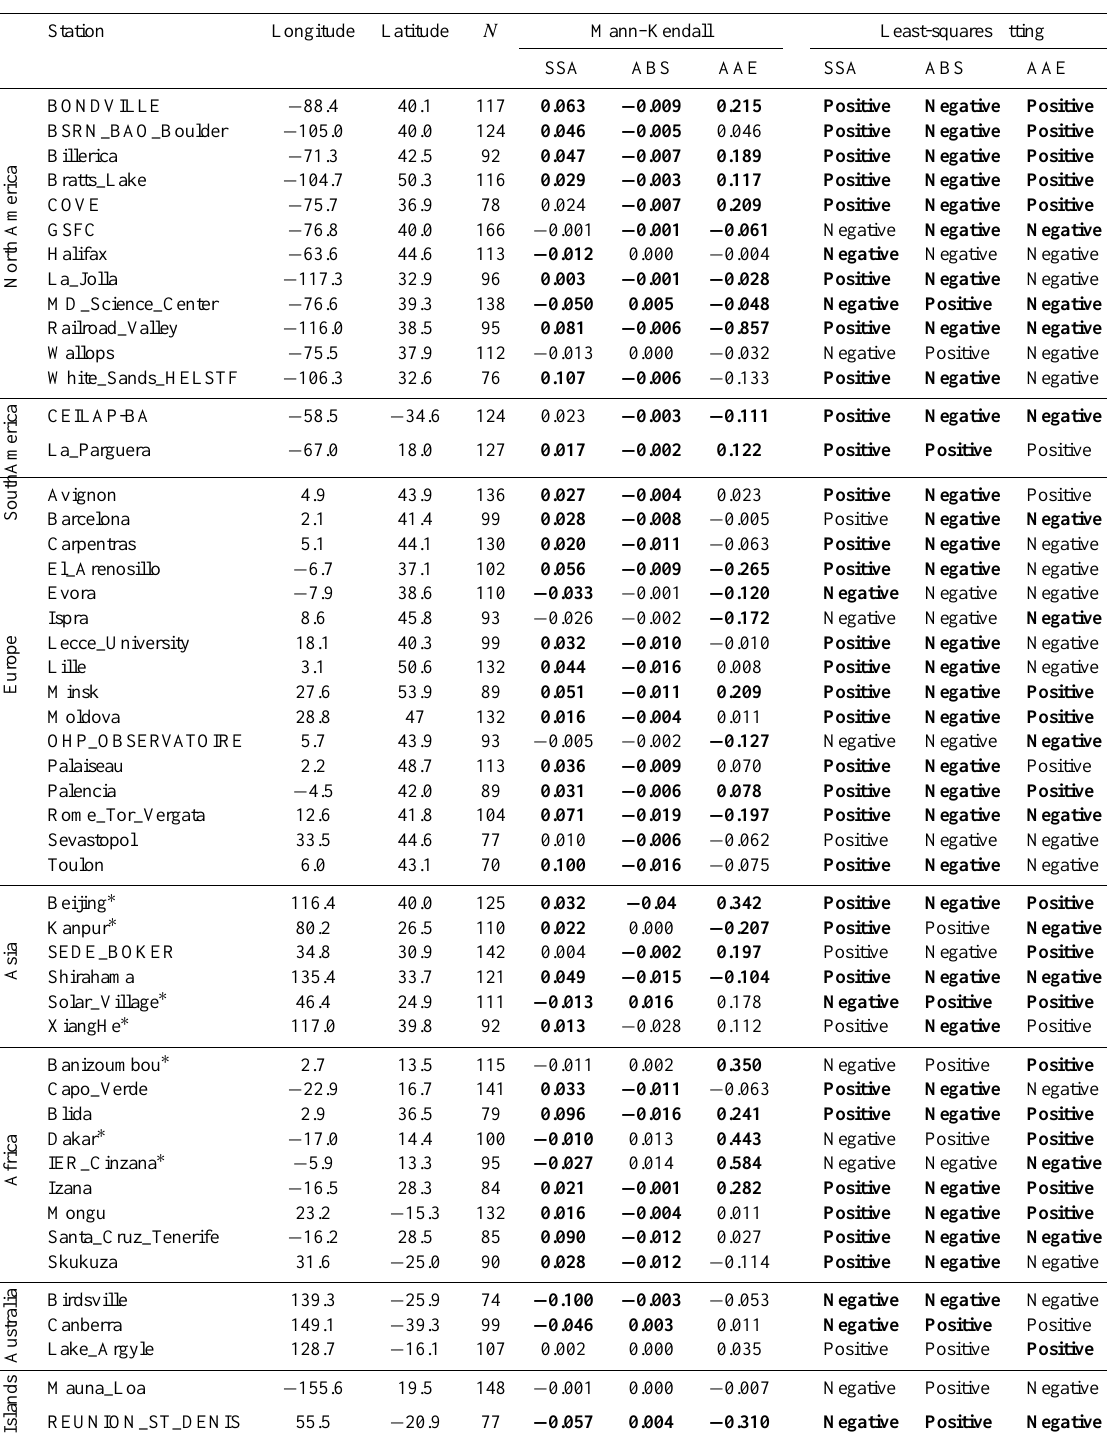
Table 2. Location, aerosol type, number of months used in the analysis ( N ), and trends (decade) for 440nm SSA, ABS and AAE at the 54 selected stations. Bold values indicate trends at 90% significance level. For least-squares fitting, as the logarithm of some parameters are used, the trends are only indicated by positive or